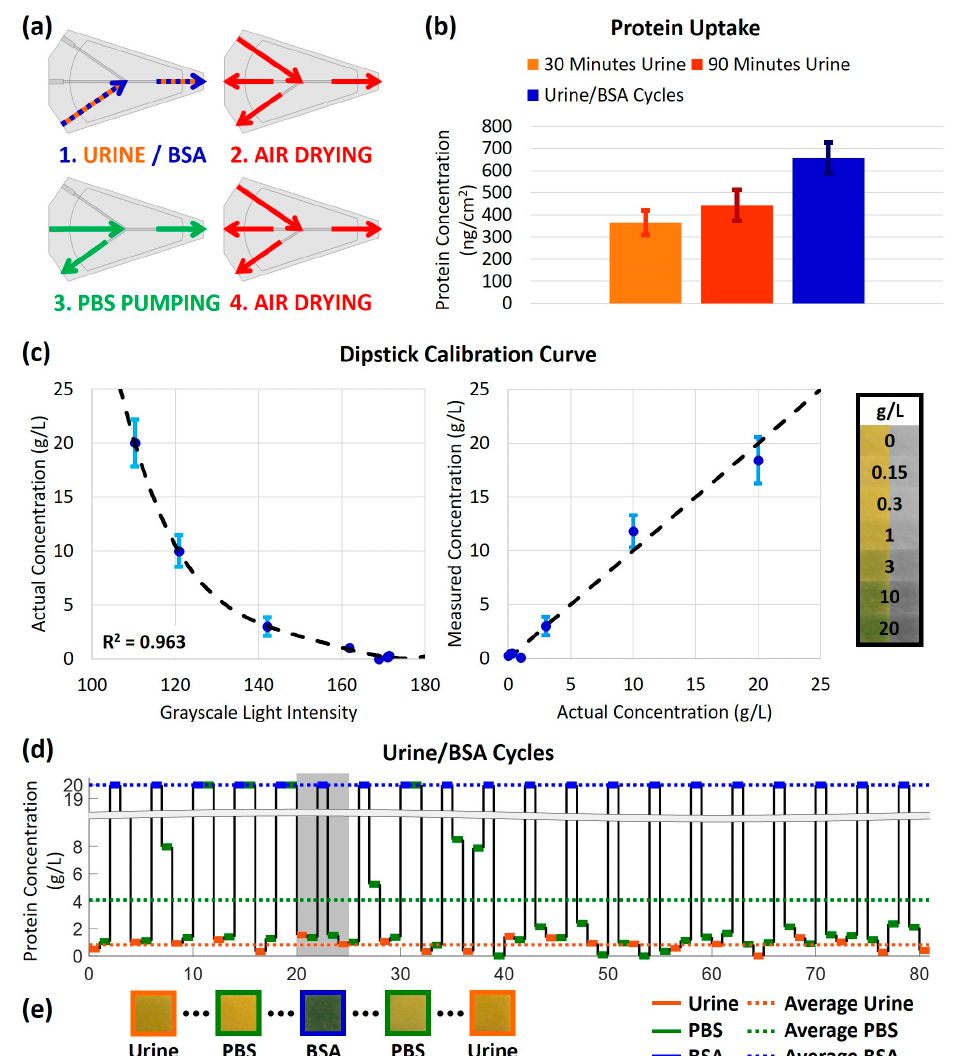
Figure 4. Performance of 3D-printed cleaning chip for urinary protein measurement: ( a ) Graphical representation of one-cycle of the modified cleaning procedure; ( b ) Protein absorption by the 3D-printed cleaning chip after 30 min of pumping urine (without cleaning), 90 min of pumping urine (without cleaning), and 20 cycles of alternating urine and high-concentration BSA samples (with cleaning between samples); ( c ) Left: calibration curve for the actual protein concentration versus the grayscale intensity of protein assay pads, calculated by least-squares curve fitting. Right: comparison of the calculated protein concentration using the calibration curve versus the actual concentration of the samples. Far right: photographs of the protein assay pads for 0, 0.15, 0.3, 1, 3, 10, and 20 g/L, shown in full color and grayscale; ( d ) Longitudinal protein concentration measurement for 20 cycles (81 pumping steps) of urine, PBS cleaning, high-concentration BSA, and a second round of PBS cleaning. Urine samples, PBS and BSA are represented by blue, green, and blue lines, respectively. Dotted lines represent the average protein concentration for the respective sample; ( e ) Photographs of the protein assay pads for Cycle 6, Steps 21–25.